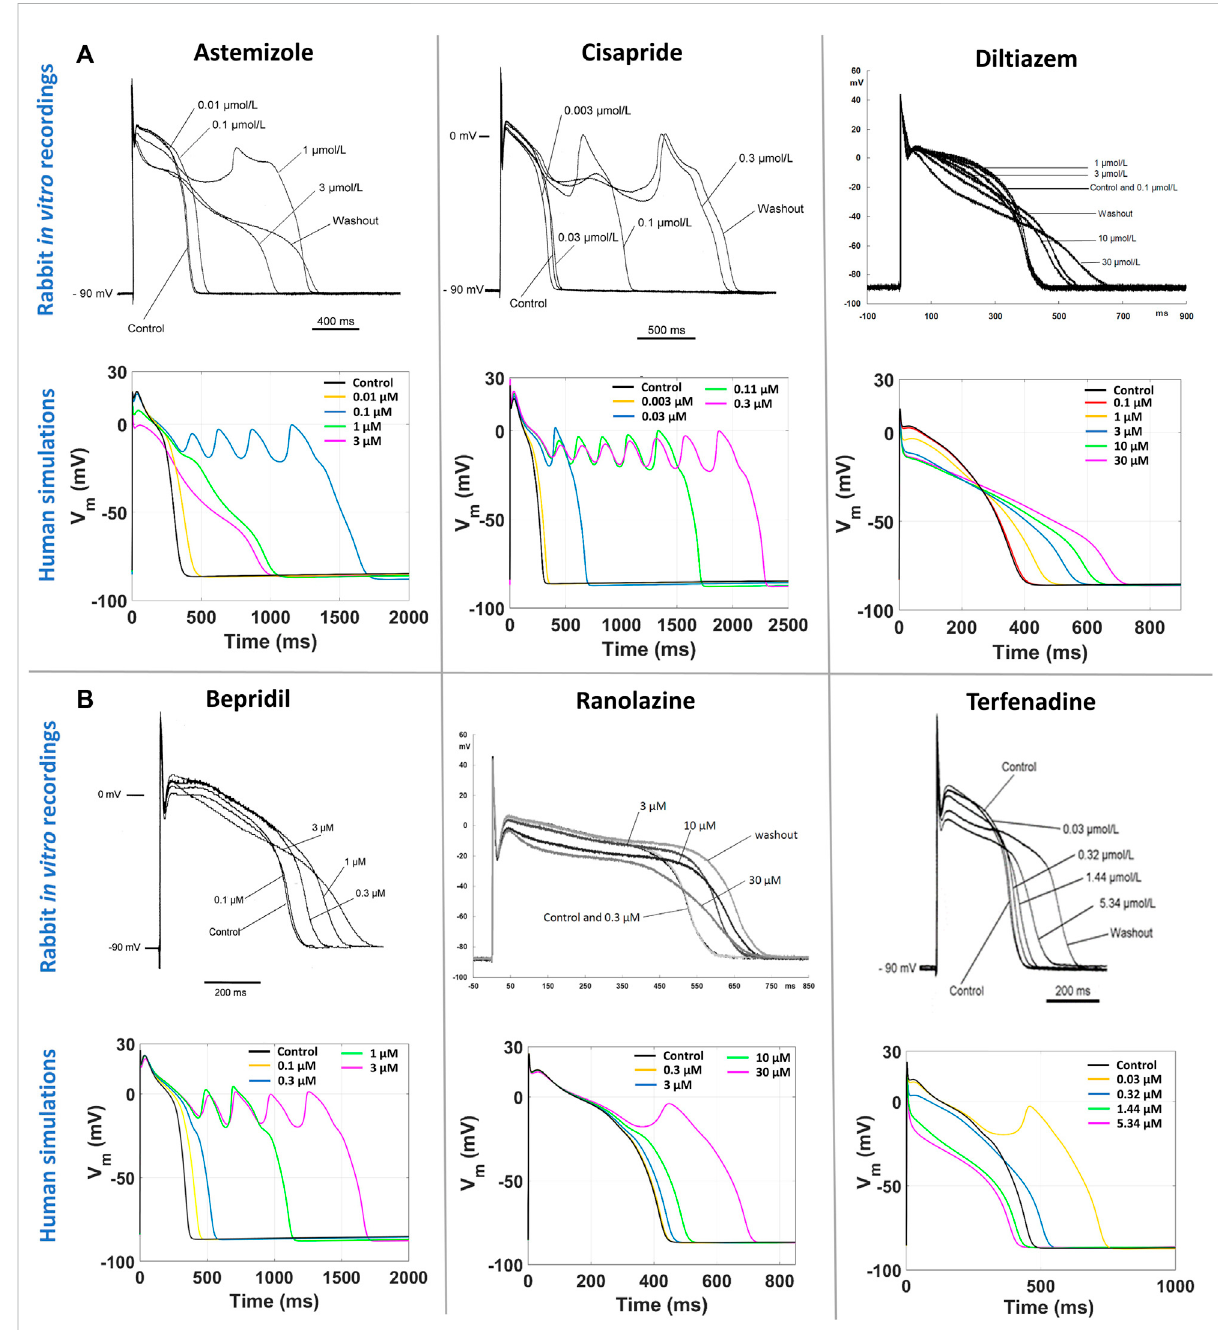
FIGURE 5 Comparison between human in silico and in vitro rabbit AP traces at slow pacing, for six illustrative compounds. In each section, experimental recordings are at the top, and simulated traces at the bottom. One representative cell/model is shown for each drug. (A) Three explicative compounds showing EADs in both simulations and experiments: astemizole (left), cisapride (center), diltiazem (right). (B) The three compounds showing disagreement in EADs occurrence between in silico and in vitro results, i.e., EADs were observed only in simulations and not in experiments: bepridil (left), ranolazine (center), terfenadine